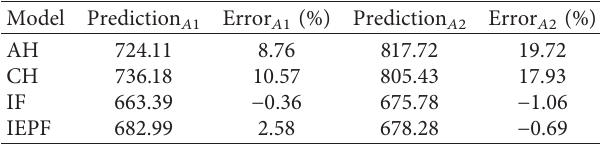
Table 5: Ultimate bearing capacity prediction for example 1.